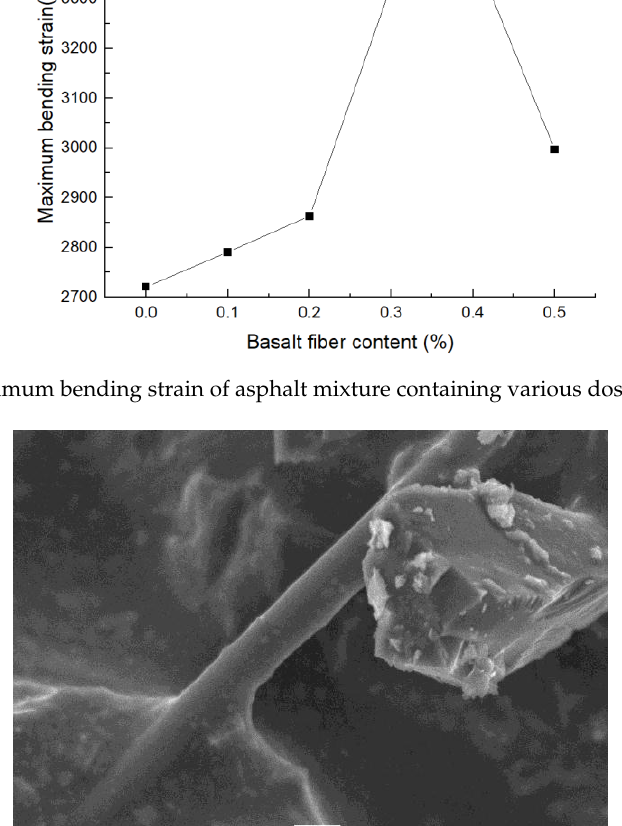
Figure 6. SEM micrographs of basalt fiber-reinforced asphalt.